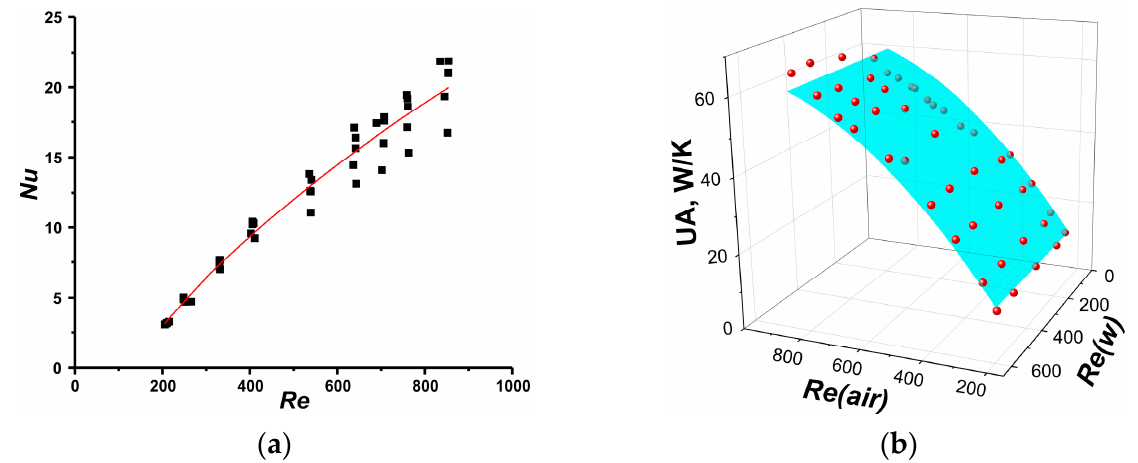
Figure 9. ( a ) Nu number correlation for radiator R3; ( b ) Comparison of experimental data (red symbols) and approximation (blue 3D surface) calculated by found correlation.